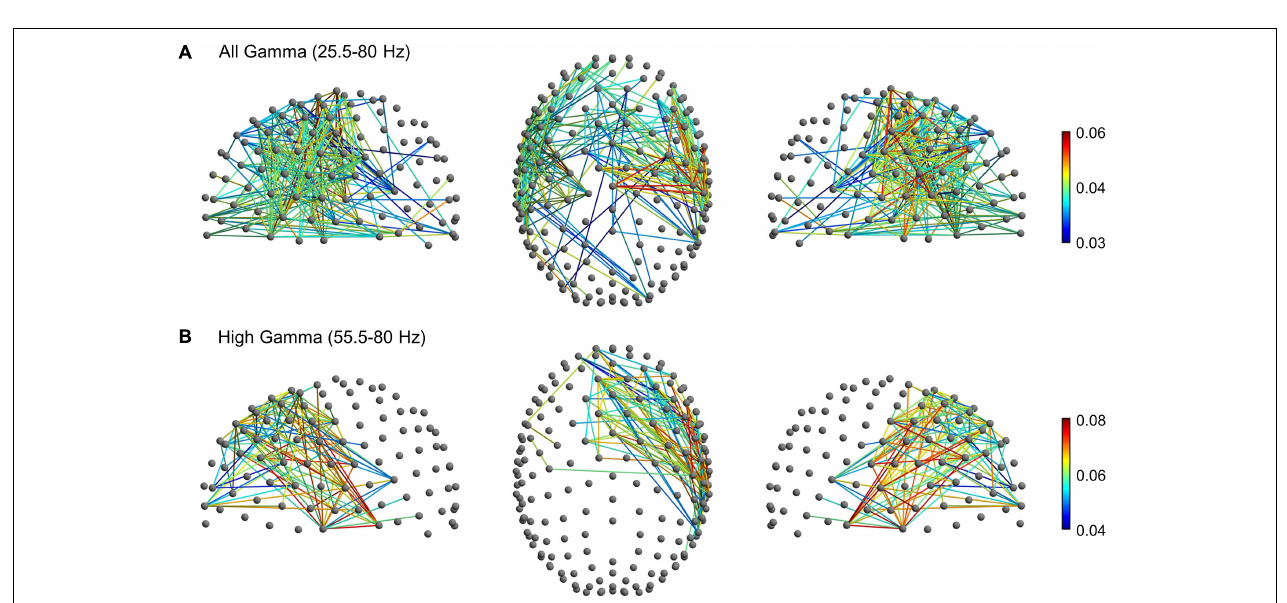
FIGURE 5 | Movement-related significant subnetwork with increased connectivity in the movement execution compared to the planning phase ( p < 0.001, corrected for multiple comparison) in the (A) broad gamma (25.5–80 Hz) and (B) high gamma (55.5–80 Hz) frequency band. The nodes and the links are depicted in two different projections (sagittal, on the left and right side; axial, in the center). Colormap indicates the difference of the mean of wPLI values between the movement execution and planning.